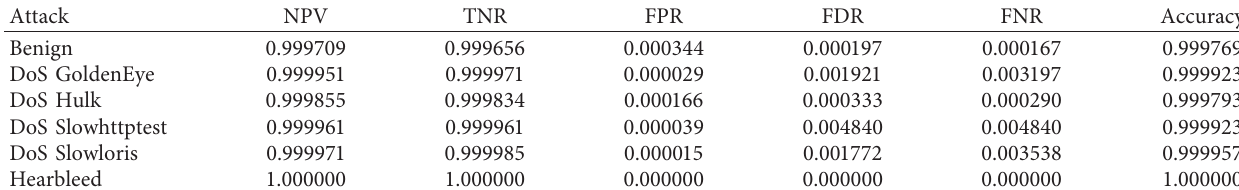
Table 5: Classification report of other metrics of the best performing estimator.